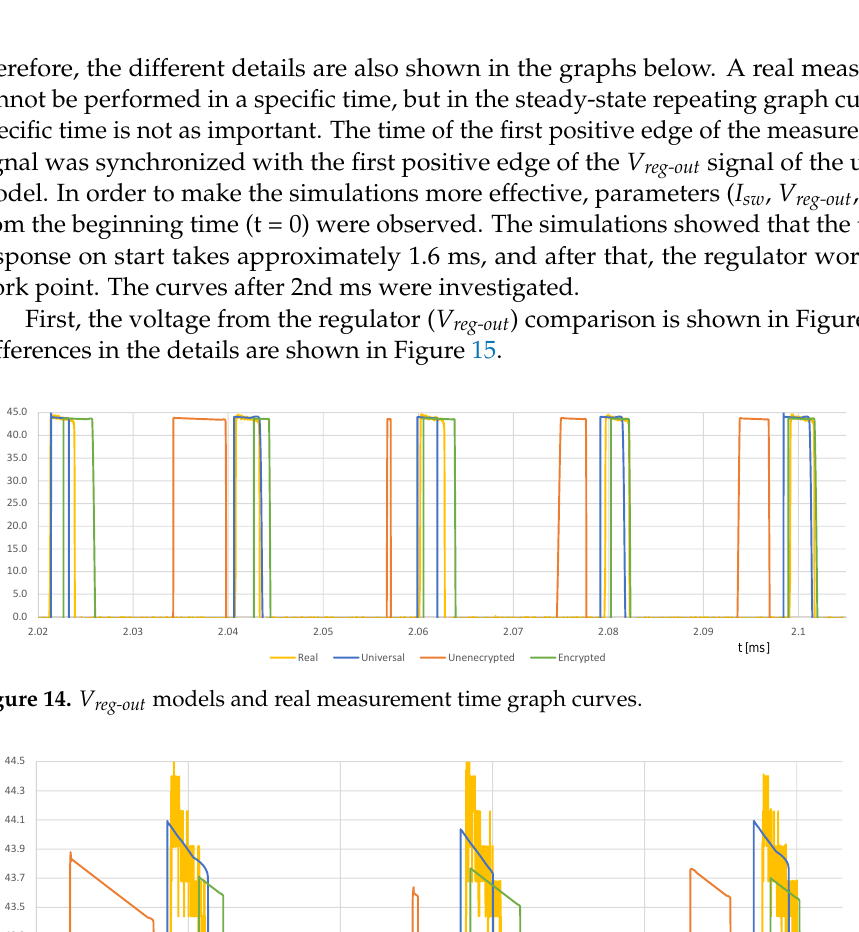
Figure 15. Detailed V reg-out models and real measurement time graph curves.